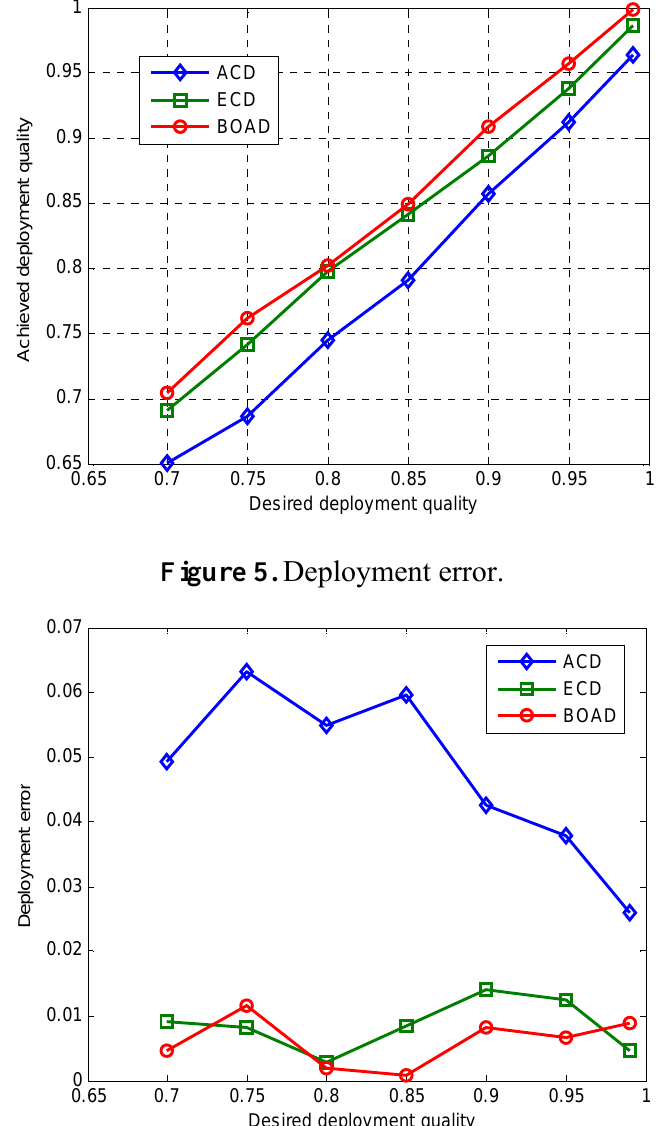
Figure 4. Desired deployment quality and achieved deployment quality.